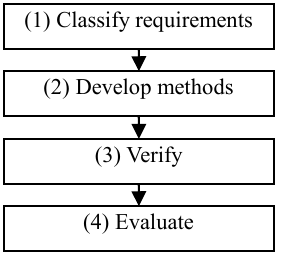
Figure 1. Examination procedure